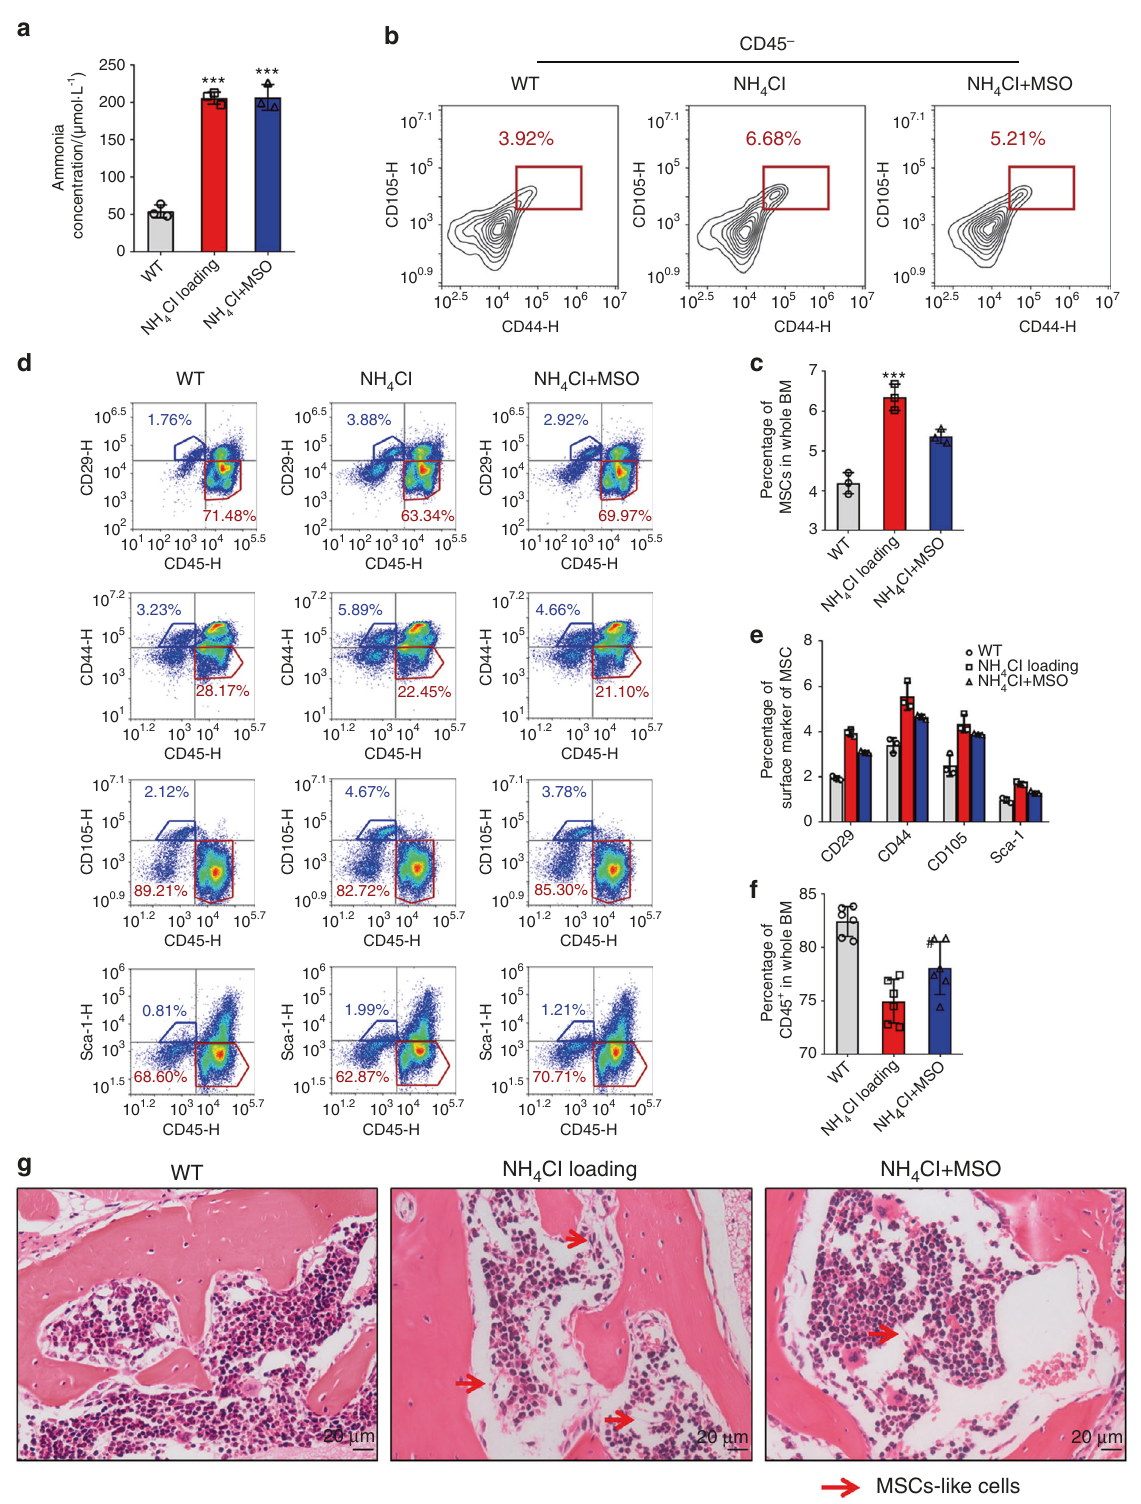
Fig. 7 The proportion of bone marrow-derived MSCs was elevated in ammonia-loaded mice. a The ammonia concentration (µmol·L − 1 ) of the wild-type mouse group, NH 4 Cl-loaded mouse group and NH 4 Cl-loaded mouse groups with MSO injection. b The percentage of MSCs in CD45- cells from mouse tibias and femurs in each group. c The statistical results of the percentage of MSCs in BM. d The percentage of the expression of MSC surface markers (CD29, CD44, CD105, Sca-1) and the expression of CD45 in each group. e The statistical results of the percentage of MSC surface marker expression in each group. f The statistical results of the percentage of CD45 expression in each group. g HE staining of the spinal column in each group. Red arrowheads, BM-derived fi broblasts; blue arrowheads, hematopoietic cells. Values are the mean ± SEM of an experiment performed in triplicate (one-way analysis of variance). * P < 0.05 versus the WT group. # P < 0.05 versus the NH 4 Cl- loaded